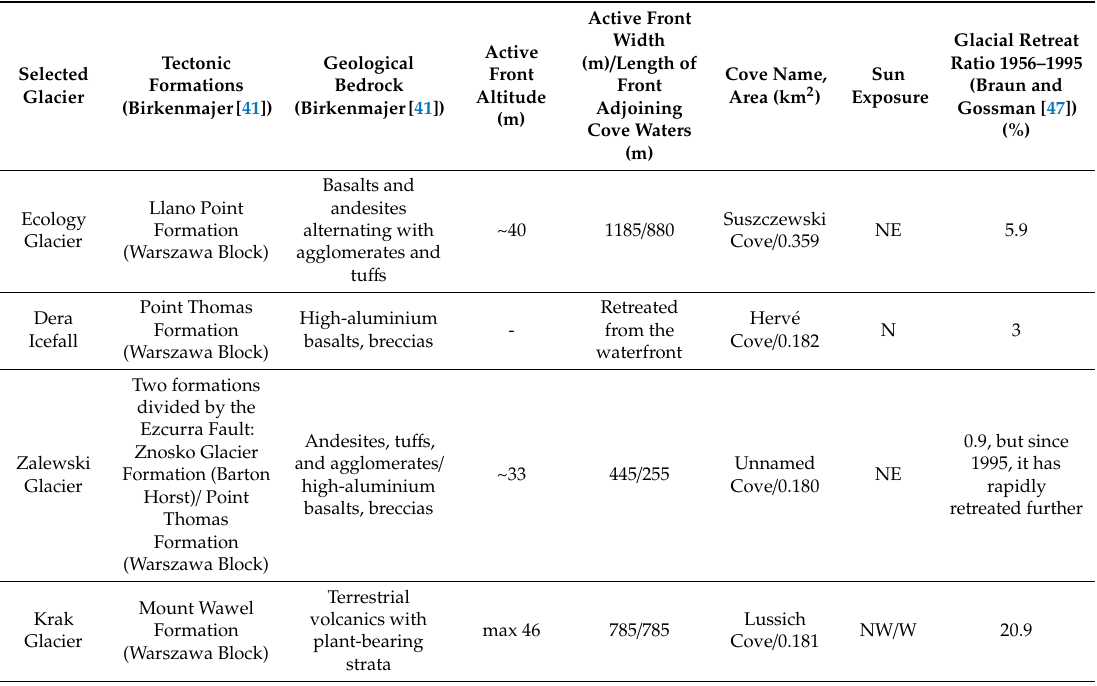
Table 1. Geological and morphological characteristics of the selected